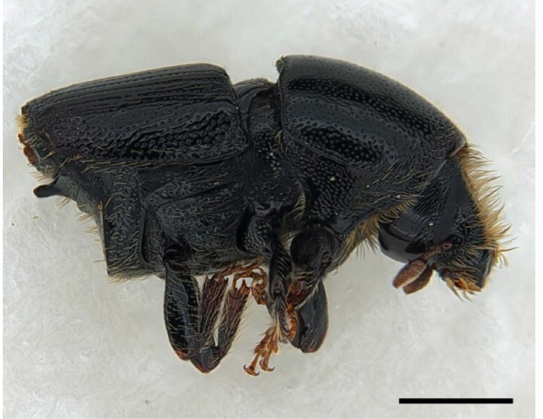
Figure 2. The insect vector, Scolytus jacobsoni (scale bar = 1 mm).